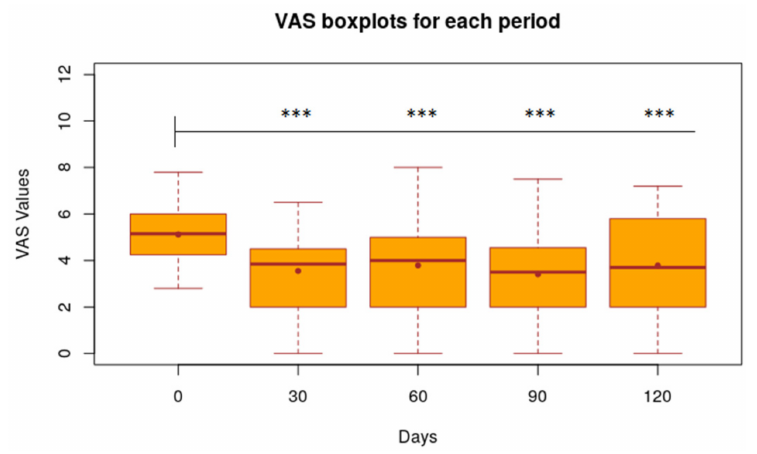
Figure 2. Statistical results of VAS values calculated for each period. Boxplot of VAS value of 32 dogs at time 0, 30, 60, 90, 120 days. Level of Significance compared to time 0: *** 1%; ** 5%; * 10%. CADLI decreased by 4.28 points ( p < 0.001) on day 30 and 4.43 points ( p < 0.001) on day 60 (Figure